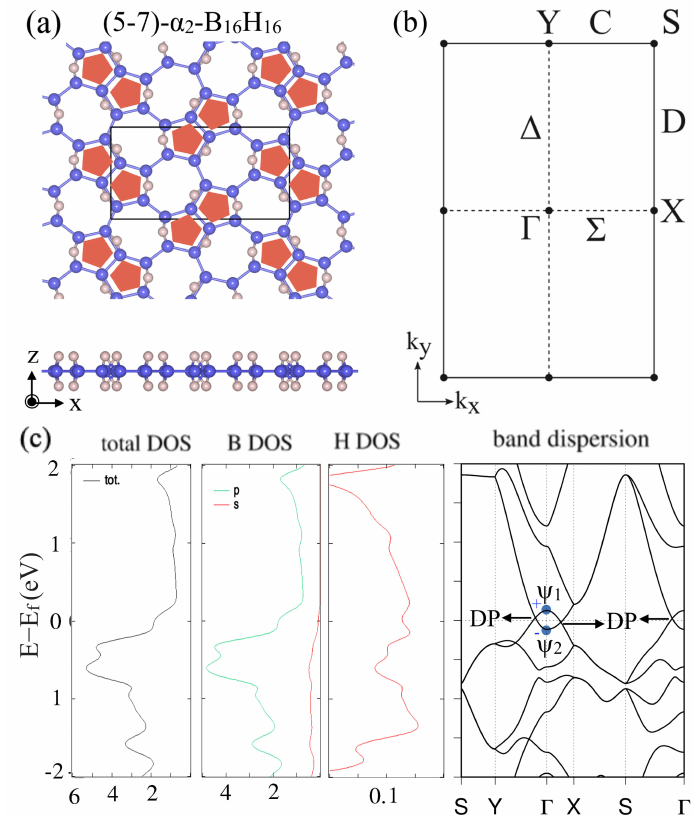
Figure 7. (5–7)- α 2 -HB. ( a ) Lattice structures of (5–7)- α 2 -HB. ( b ) BZ of (5–7)- α 2 -HB. ( c ) Electronic band structure and density of state of (5–7)- α 2 -HB. The Dirac points (DP) are parts of the Dirac nodal line (adapted from